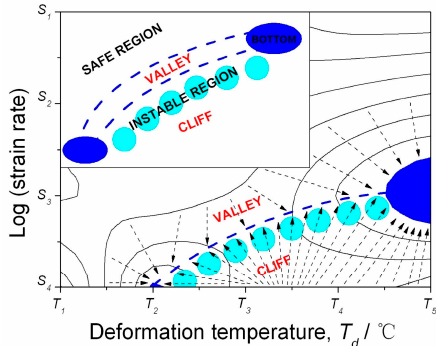
Figure 13. Schematic illustration of the instability criterion for PM/Wrought dual superalloy.